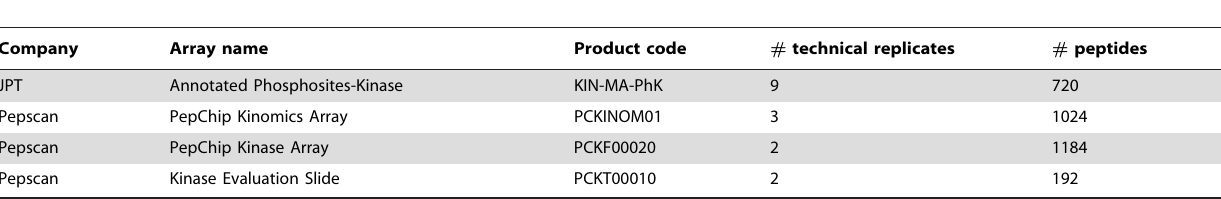
Table 1. Off-the-shelf kinome microarrays that the PIIKA 2 web interface allows the user to select.